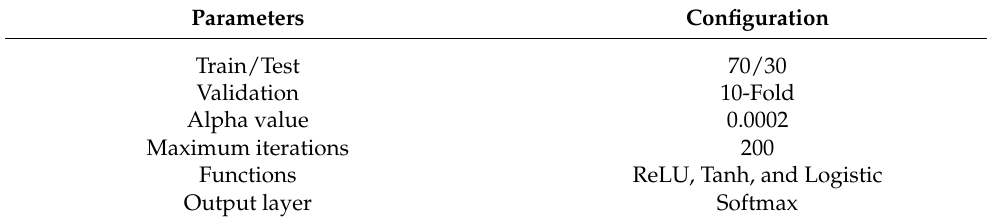
Figure 9. The integration of DL into the recognition process. The DL architecture was trained with spectral coefficients and features created by M3GP. Table 1. The experimentation parameters considered in our DL architecture.